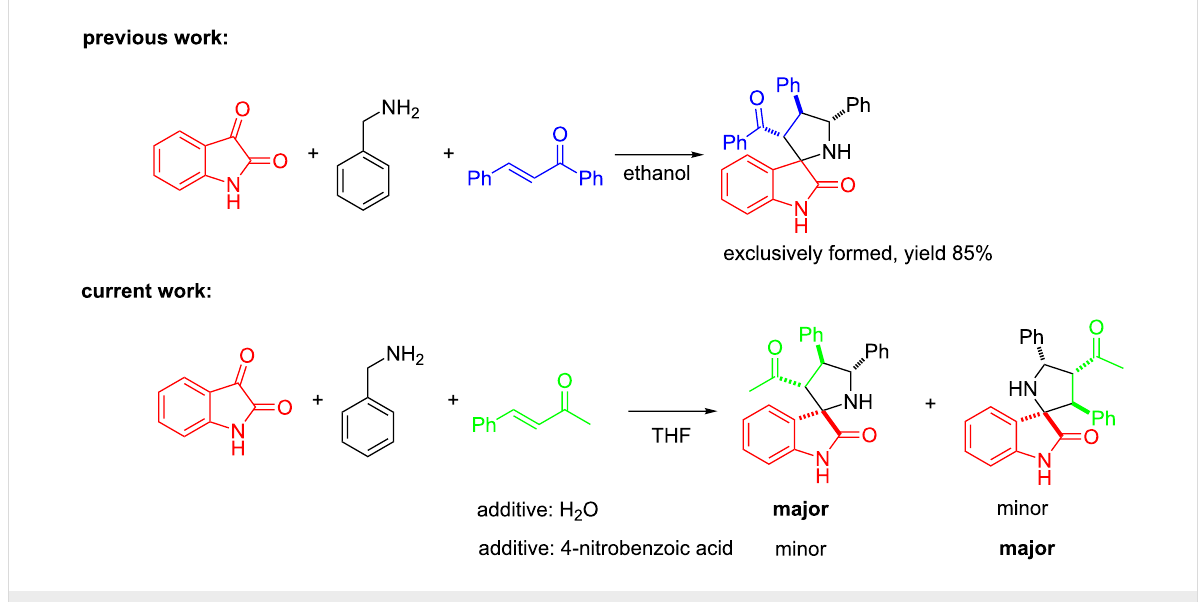
Scheme 1: Different regioselectivities in 1,3-dipolar cycloaddition of azomethine